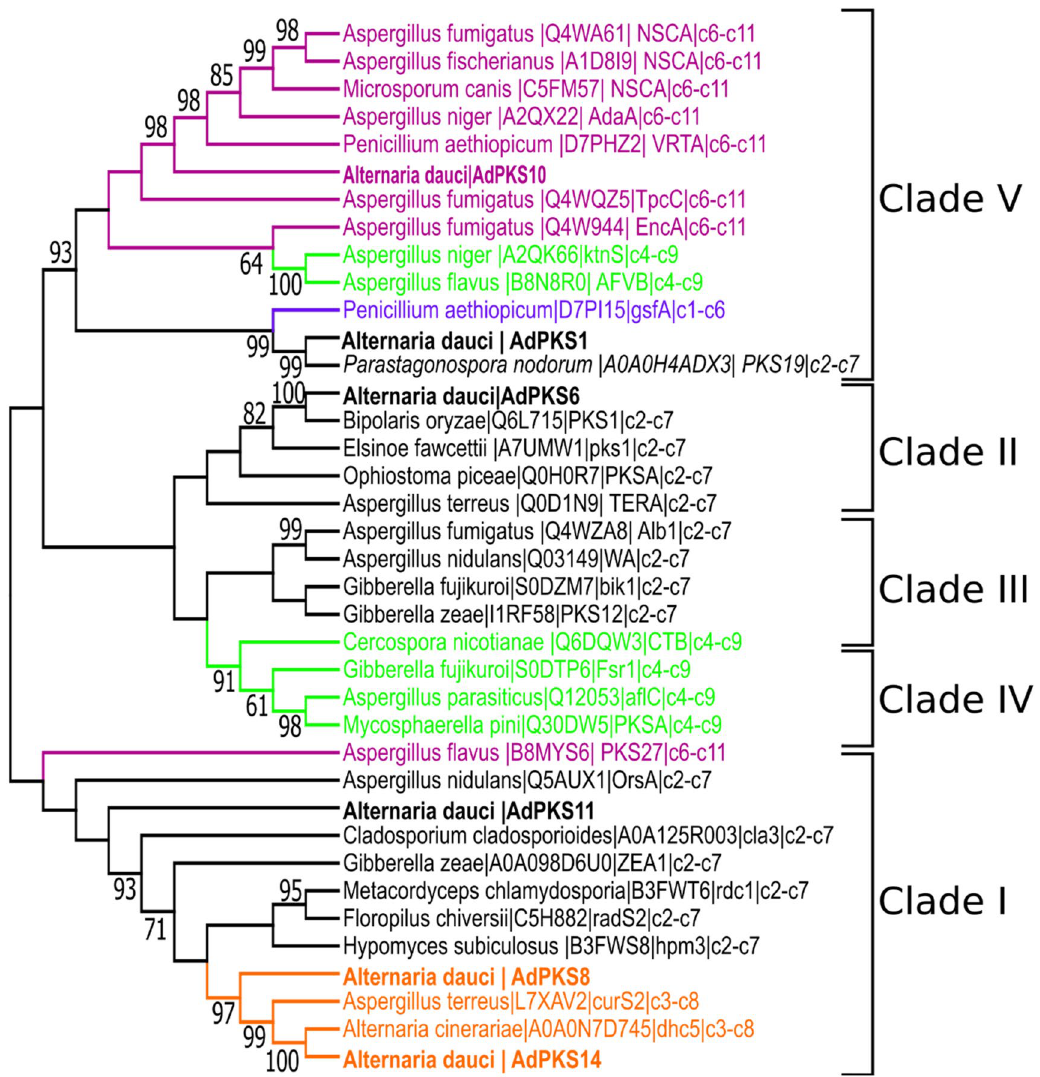
Figure 7. Phylogenetic tree of PT domains of 38 selected NR-PKS sequences. The regioselectivities catalyzed by PT domain are indicated when known. Phylogenetic analysis was conducted using the bootstrap (1000) maximum parsimony method. PKSs were grouped in five monophyletic clades consistent to those described by 27